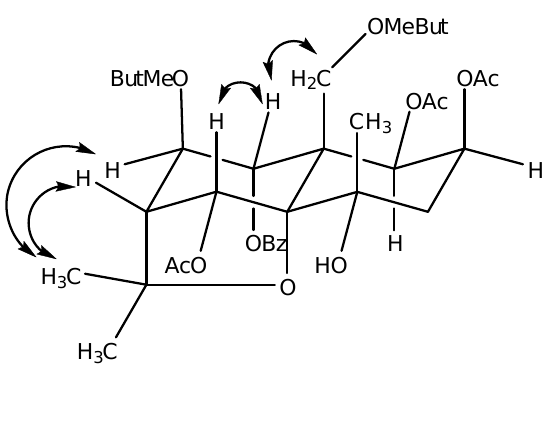
Figure 2 . Major NOESY correlations in 1